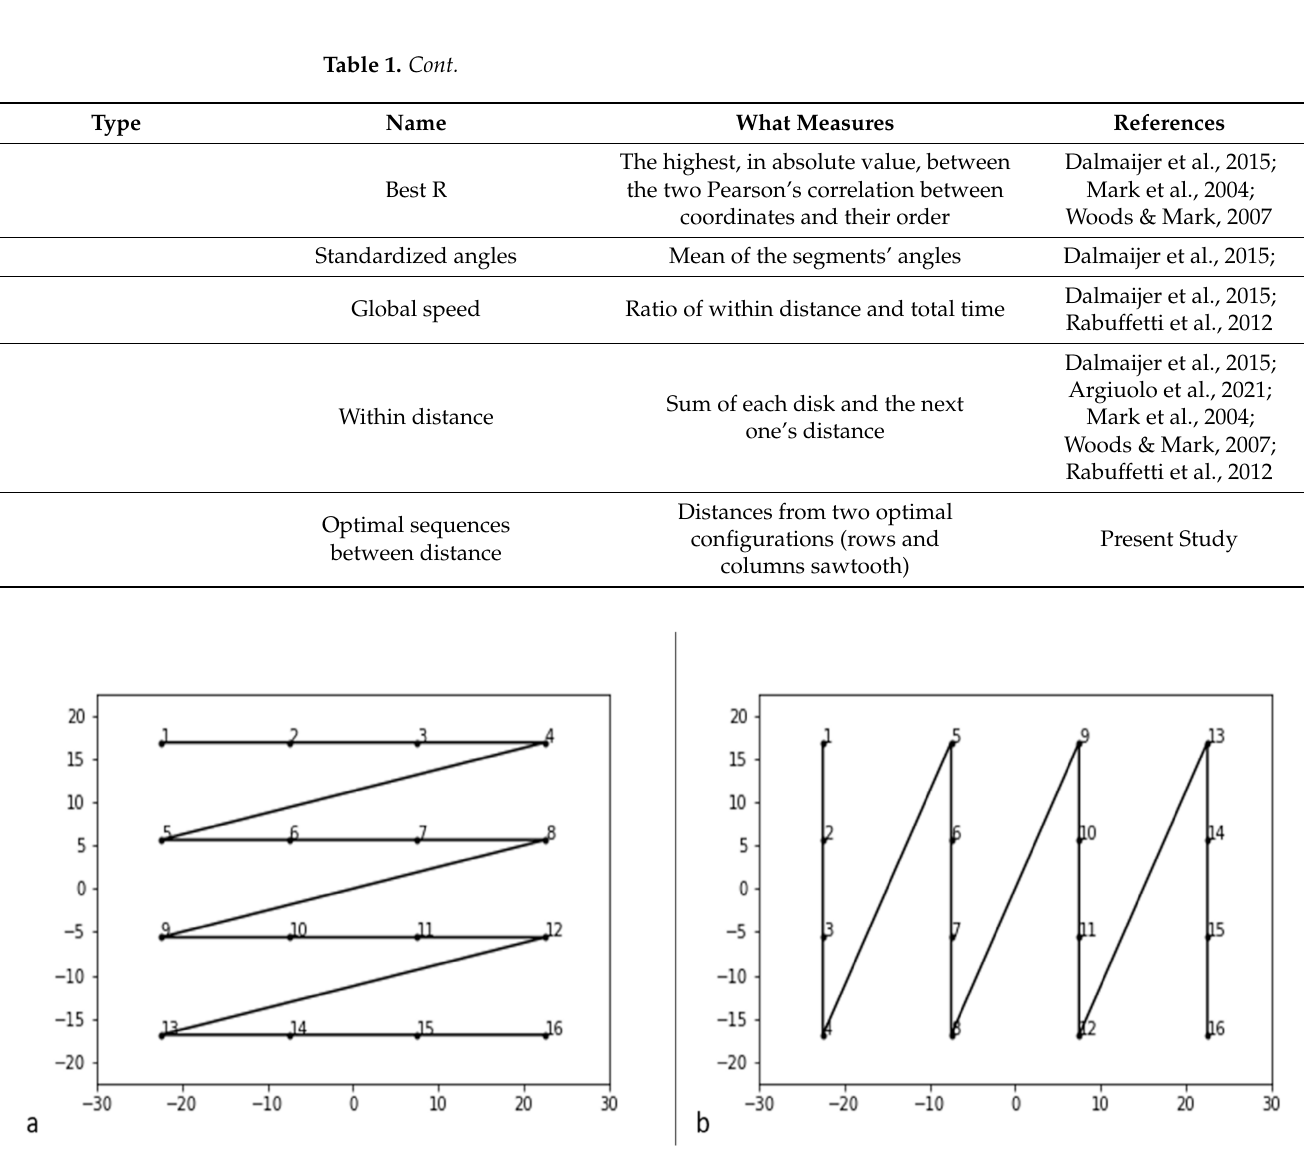
Figure 2. The two optimal sequences: ( a ) the first goes by rows (OS1); ( b ) the second goes by columns